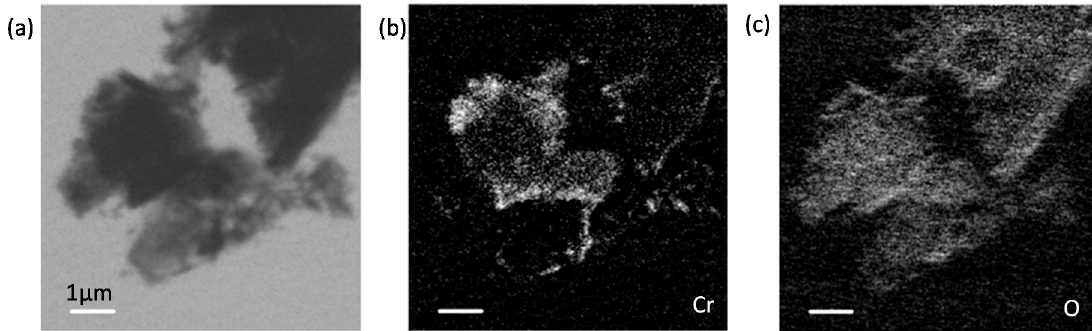
Figure 7. ( a ) Scanning transmission X-ray microscopy (STXM) image of GGBS-CH-S3 taken at